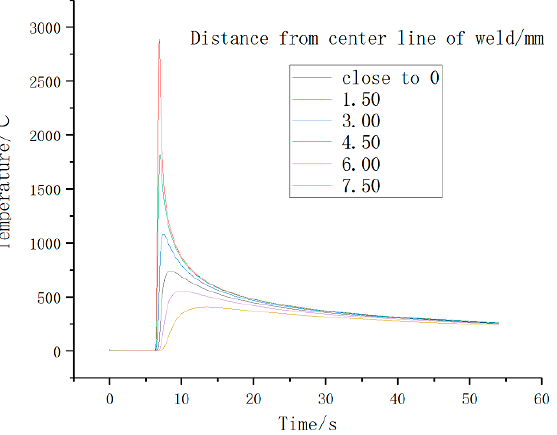
Figure 9. Thermal cycle curve of typical node on the path vertical to the weld.